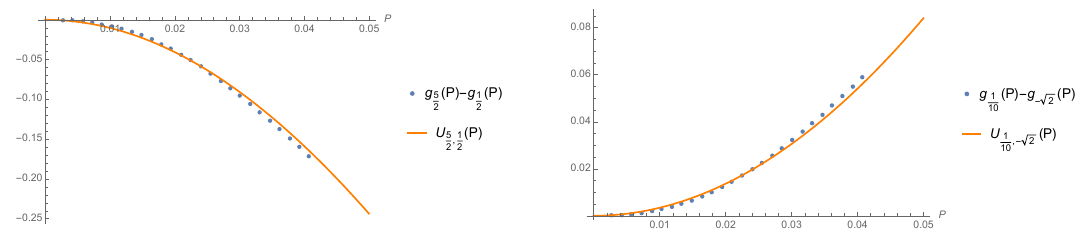
Figure 3 . Comparison of the di(cid:11)erence of g -functions for di(cid:11)erent values of s and the combina- tion (4.23) of the bulk Liouville one-point